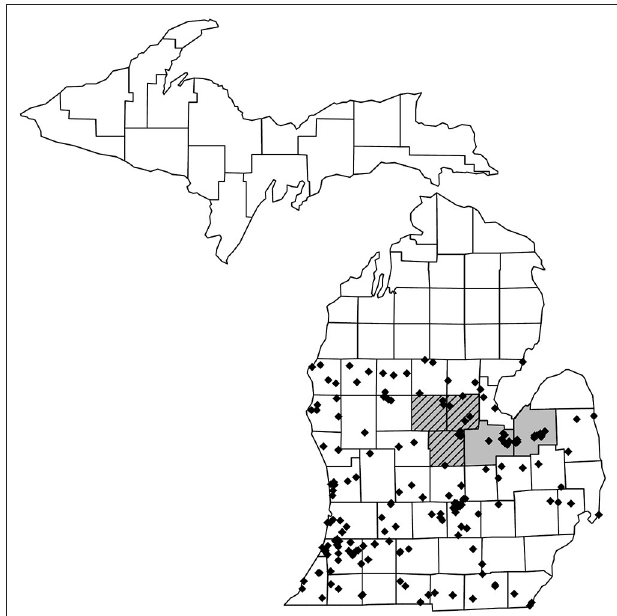
FIGURE 1 | Map of Michigan showing the collection locations for the 1,492 wild bee specimens that were used for pollen load analysis. Specimens were taken from counties south of the floral tension zone to reduce possible regional effects. Honey bee hives for our study were placed out in counties highlighted in gray during 2017 and 2018 and in counties highlighted in hatched gray during 2018